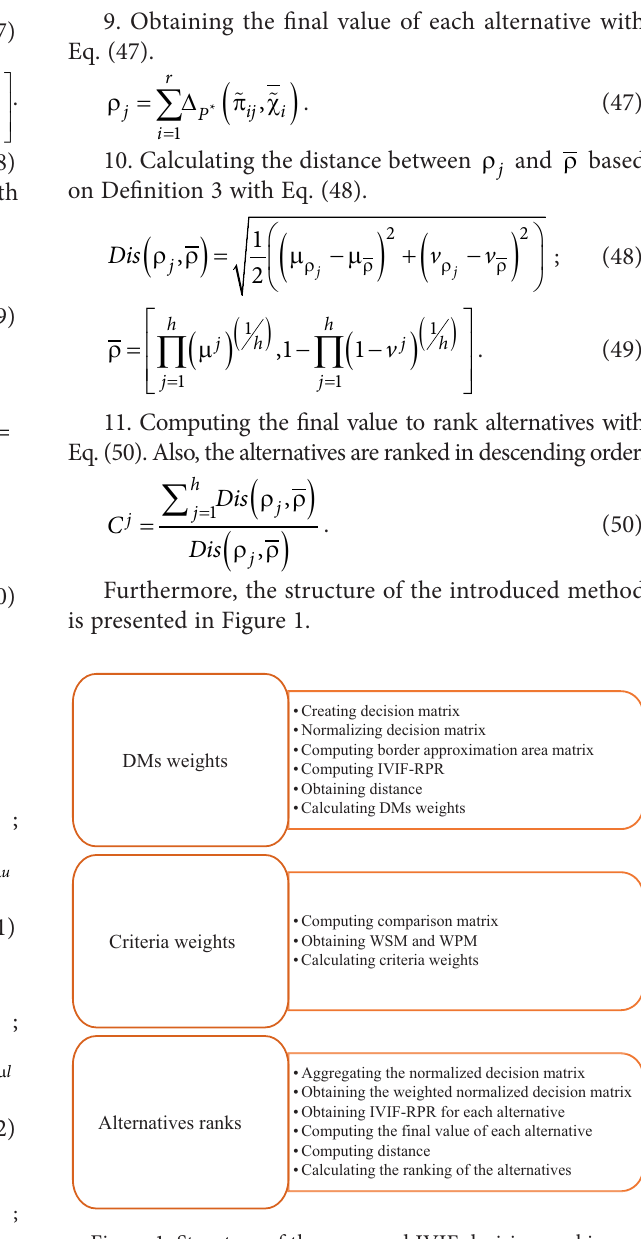
Figure 1. Structure of the proposed IVIF decision-making